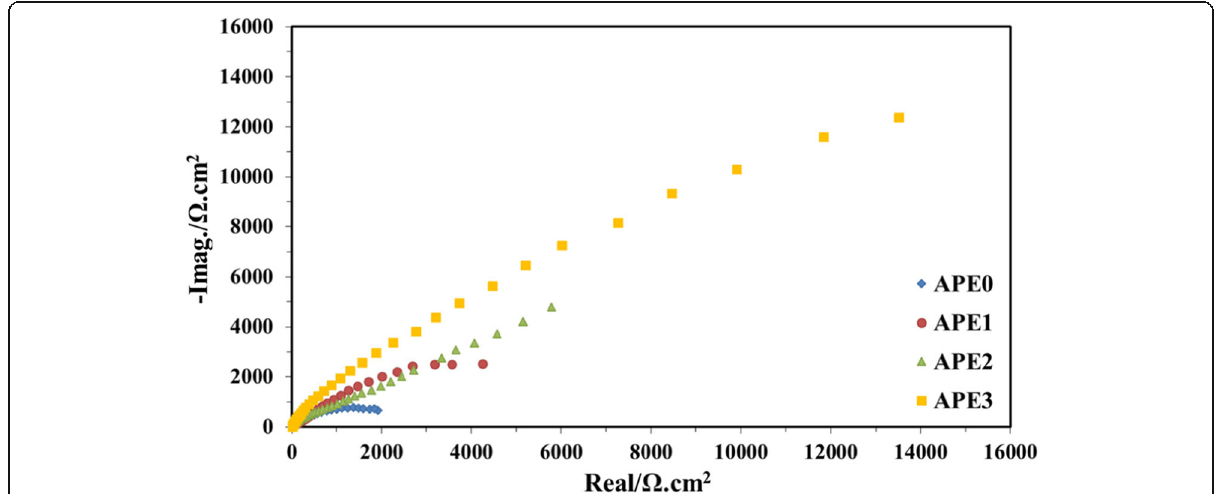
Fig. 4 Nyquist curves for steel samples after 7-day immersion in NaCl brine containing 0 to 3% (v/v) APE